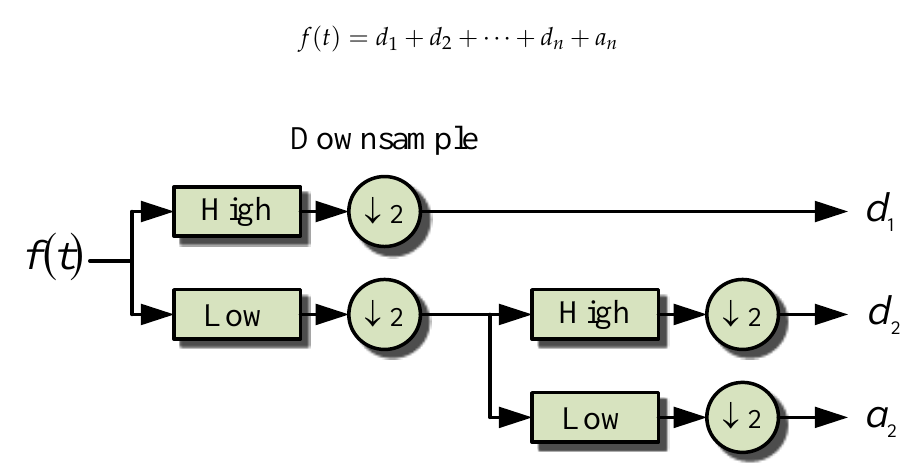
Figure 1. The structure of the multi-resolution analysis (MRA).